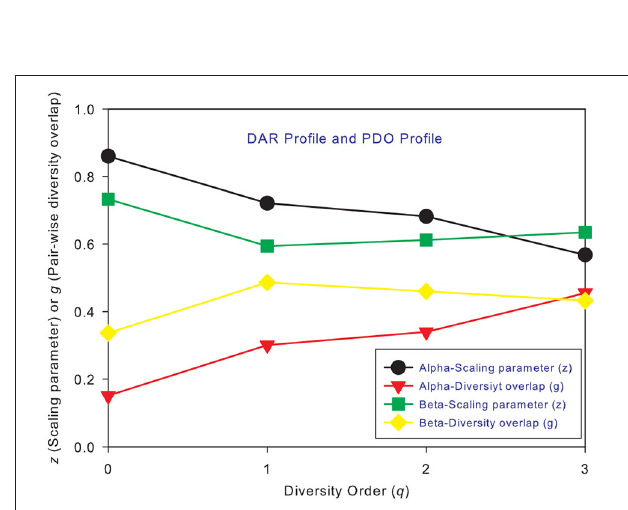
FIGURE 2 | The intra-DAR profile and intra-PDO profile for the alpha- and beta-diversity scaling, respectively: (i) the alpha-DAR profile monotonically decreases with q , and its counterpart PDO profile monotonically increases with q ; (ii) the beta-DAR profile is valley-shaped, and its counterpart PDO profile is mountain-shaped; (iii) the difference between alpha and beta profiles seems largest at diversity order q = 0–1, and smallest at q =